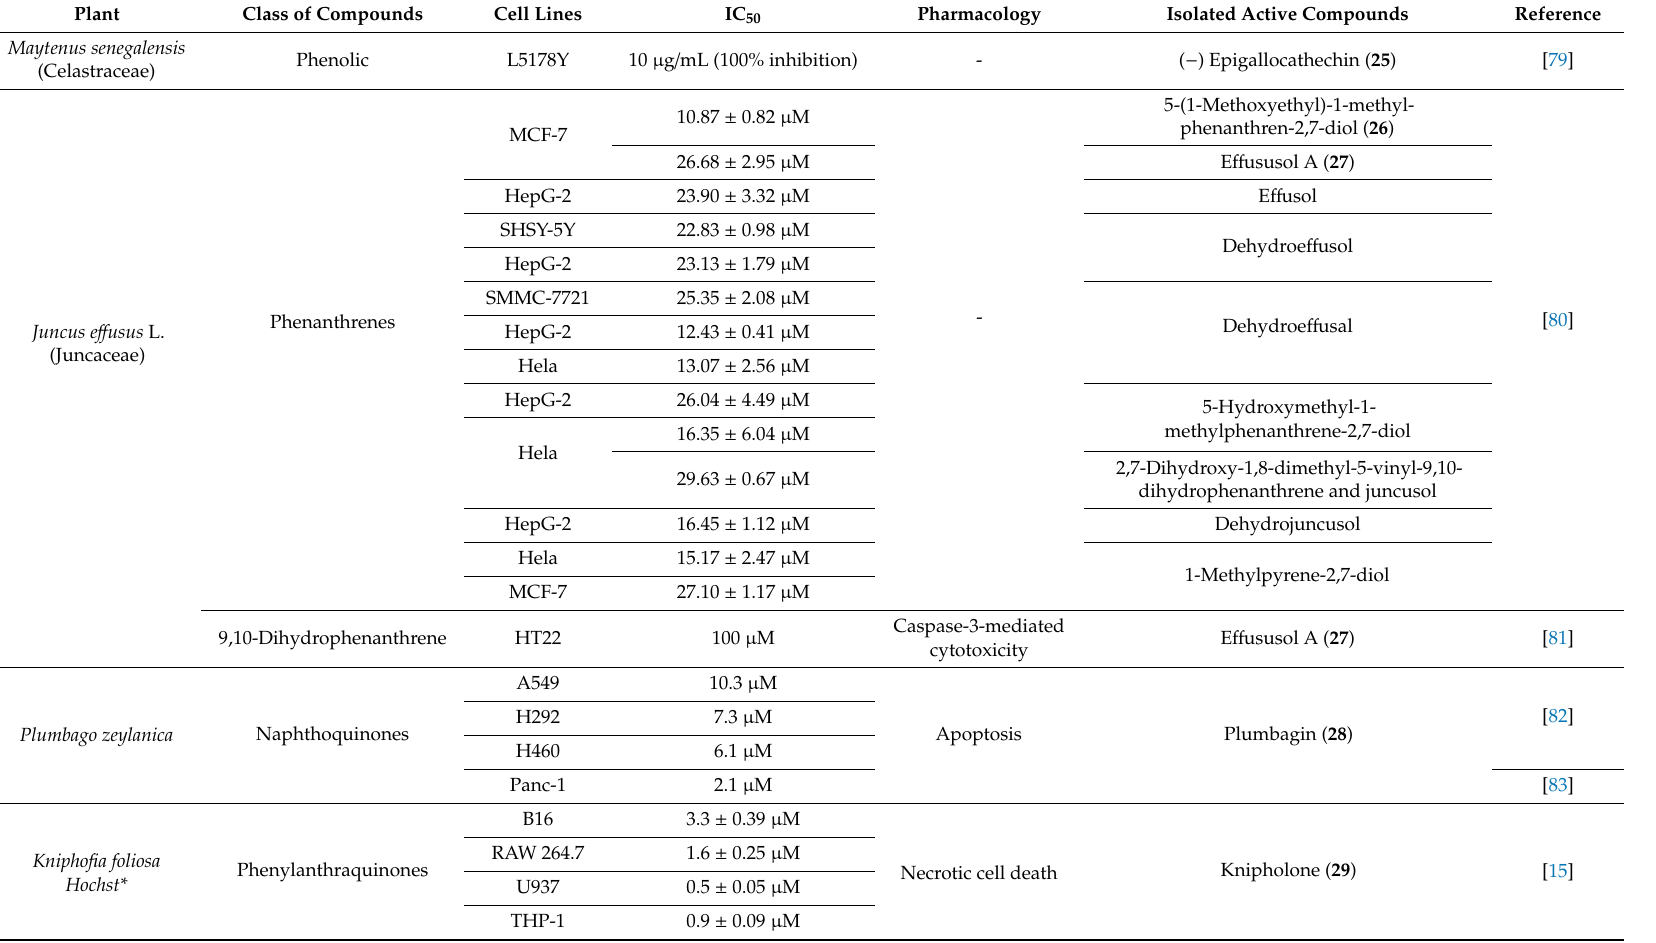
Table 3. Phenolic compounds isolated from medicinal plants that are traditionally used to treat cancer in